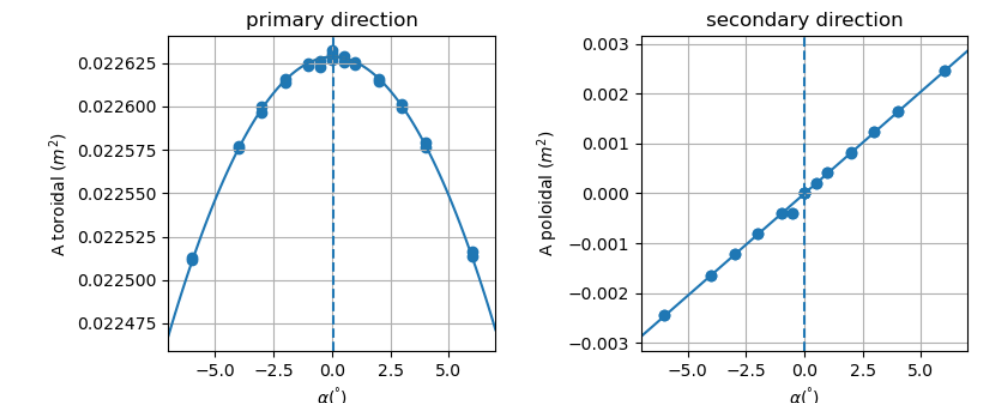
Figure 13. Toroidal (primary, left) and poloidal (secondary, right) effective area values as a function of the angle of rotation for the 3AX sensor; the angle of misalignment is represented by the vertical dashed line.